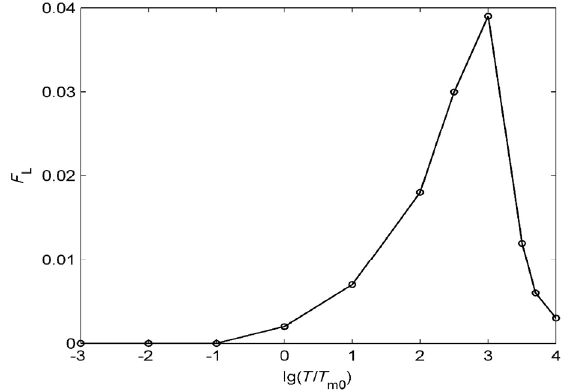
Fig. 7 Dependence of average friction force on